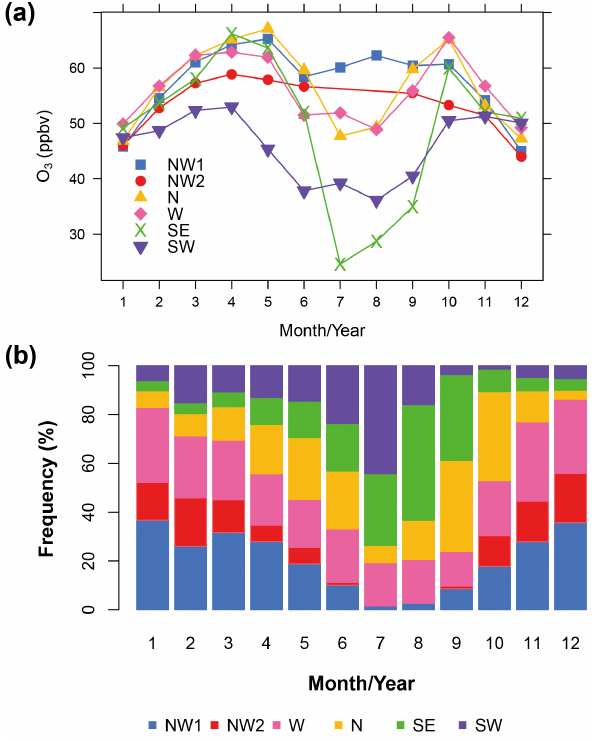
Figure 9. Monthly variations of (a) O 3 concentrations of six clus- ters and (b) their monthly